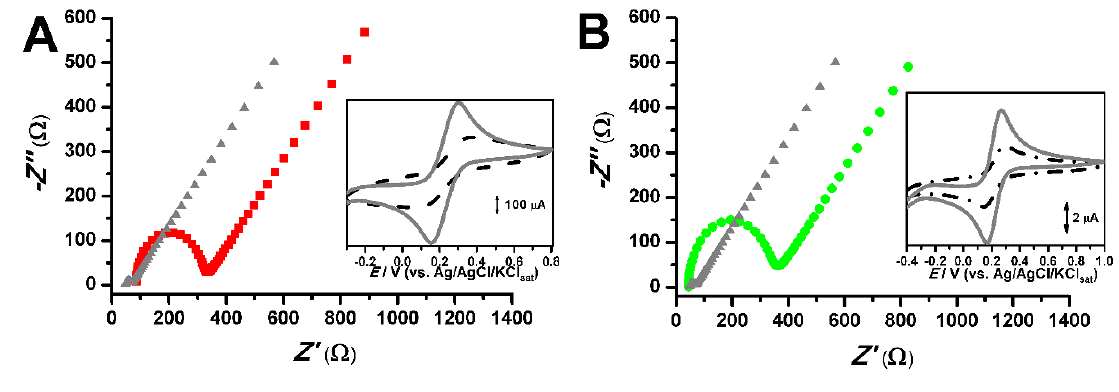
Figure 4. Electrochemical impedance Nyquist plots of CP control ( ▲ ). (A) CP PI20% ( ■ ) and (B) CP EA7% ( • ). Insert: the related cyclic voltammetry (CV) scans. CP control (—-), CP PI20% (- - -), and CP EA7% (- • -). All CV and electrochemical impedance spectroscopy (EIS) assays were performed with 0.05 mol.L − 1 potassium ferri/ferrocyanide in 0.1 mol L − 1 KCl solution.